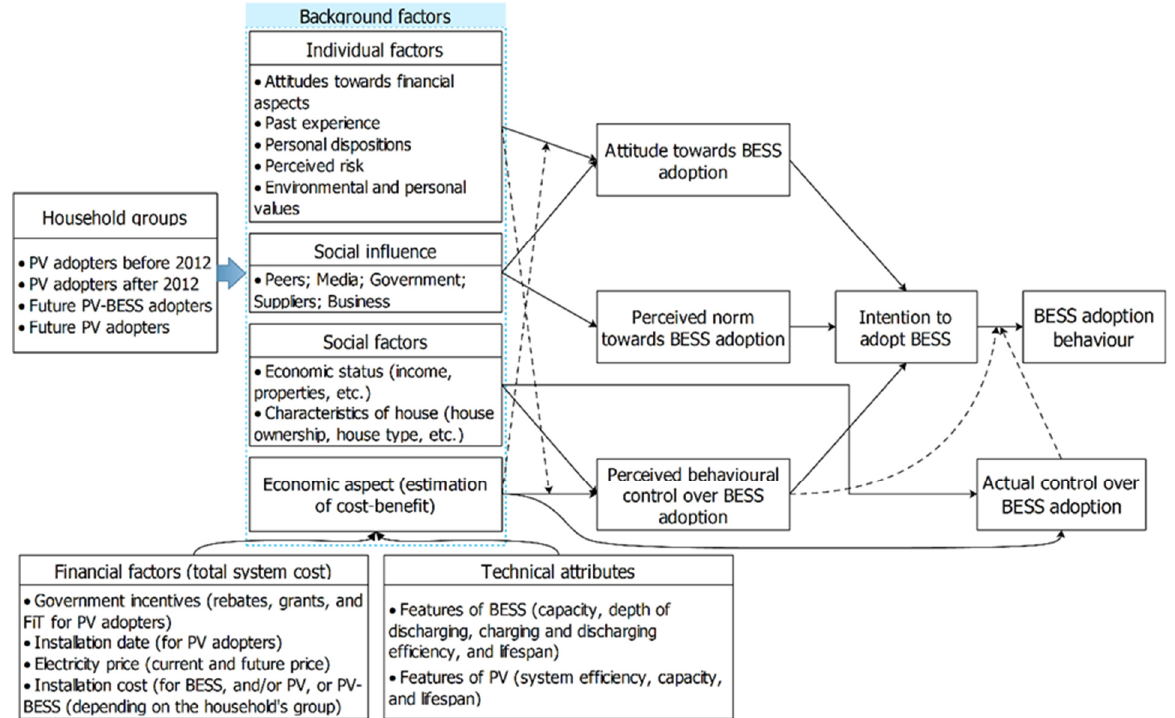
Figure 6. Example of a behavioural decision-making model for BESS adoption.